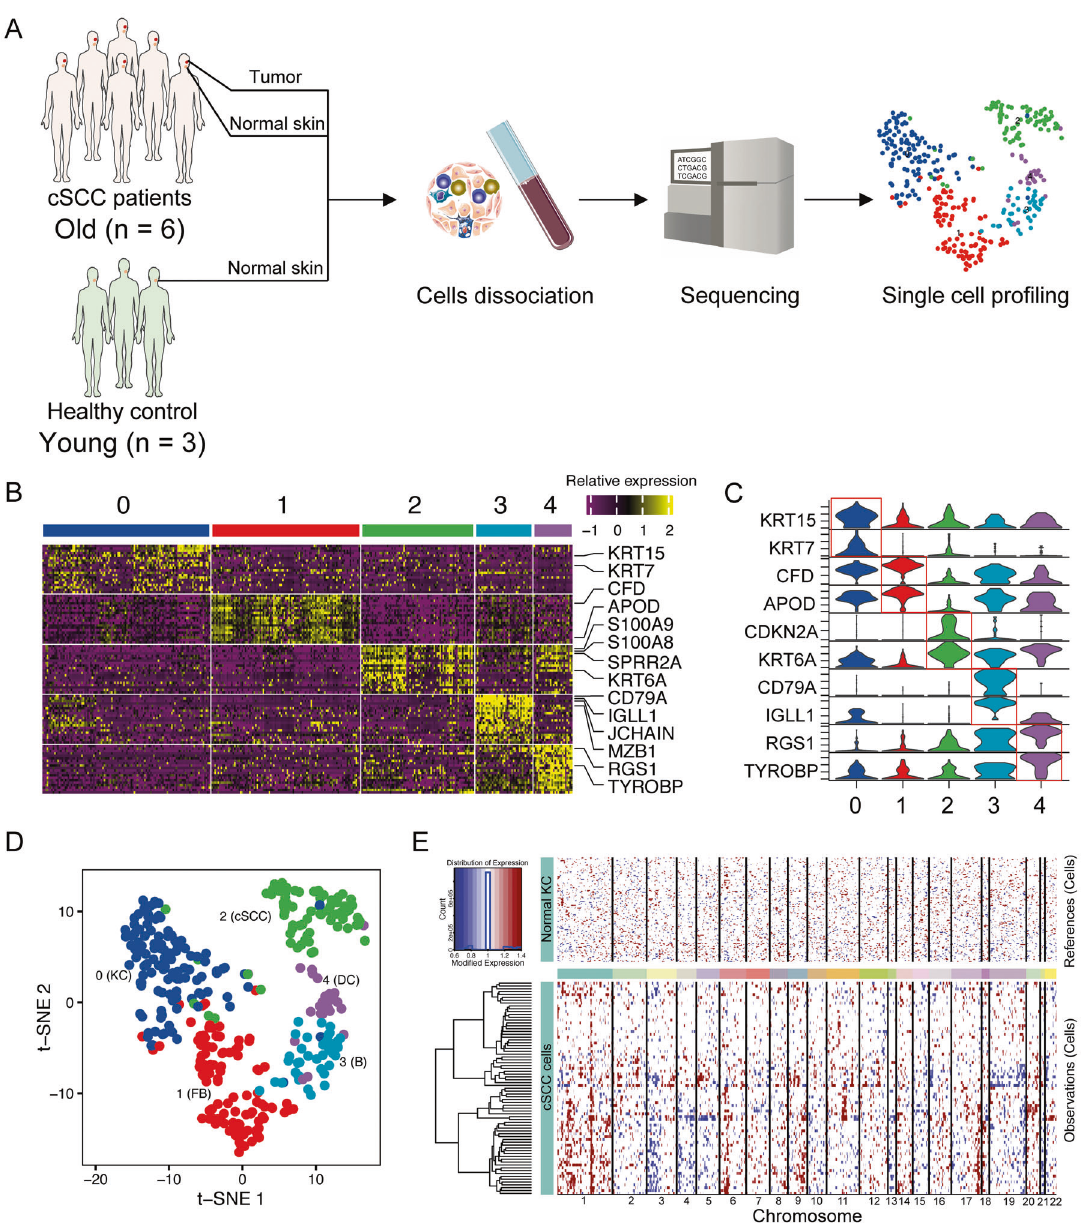
Fig. 1 ScRNA-seq pro fi ling of the cSCC tumor environments. A Work fl ow of cSCC patients and healthy control sample processing for scRNA- seq. B Heatmap showing the expression of representative genes in each cluster. The top bars label the clusters corresponding to speci fi c cell clusters. C Violin plots displaying the expression of well-known representative markers across the cell types identi fi ed in cSCC. D T-distributed stochastic neighbor embedding (t-SNE) plot shows the annotation for cell types. E Heatmap showing large-scale CNVs of normal KC and cSCC cells. The normalized CNV levels were shown, the red color indicates high CNV level and blue indicates low CNV Dysregulated genes and pathways in cSCC In order to identify the DEGs between cSCC and normal KCs at a single-cell level, we performed differential expression analysis between KCs (Cluster 0) and cSCCs (Cluster 2) cells. A total of 161 DEGs were identi fi ed including 119 upregulated and 42 down- regulated genes in cSCC (adjusted P value <0.05 and |logFC| > 1), which indicates that most of DEGs were upregulated in cSCC (Fig. 2A). The top 10 signi fi cantly upregulated genes were highlighted, including S100A9 , S100A8 , SFN , S100A7 , S100A2 , SPRR2A , FABP5 , ISG15 , KRT6B , and KRT16 . In speci fi c, seven